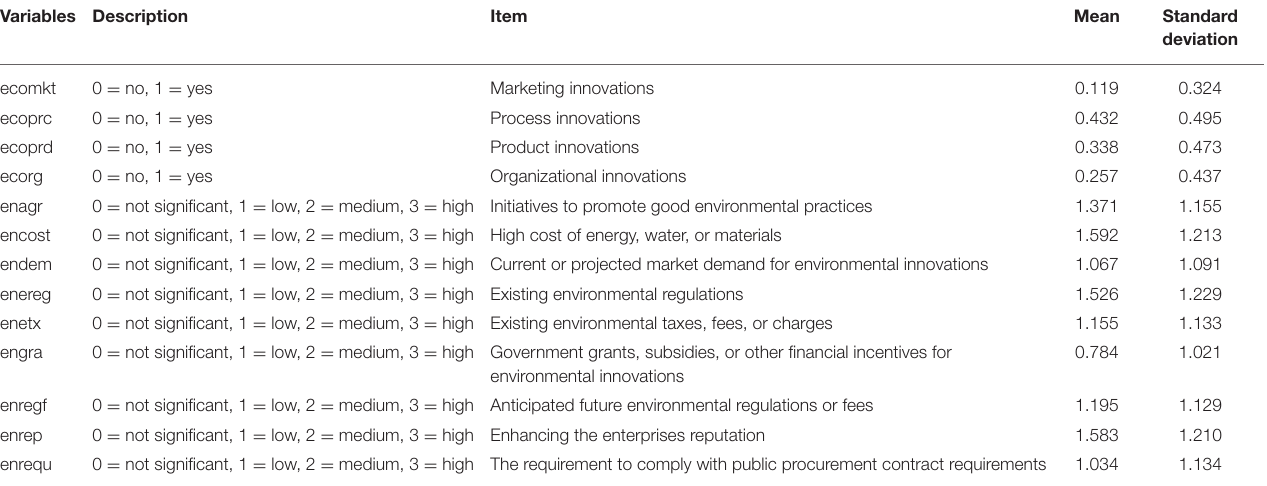
TABLE 1 | Summary statistics and variable’s description.